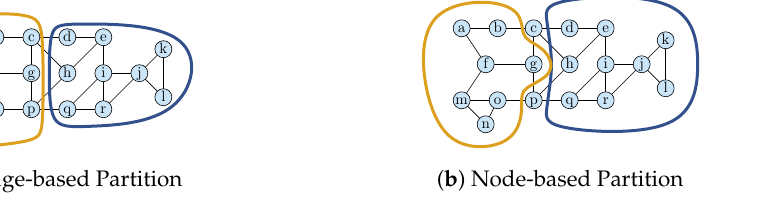
Figure 2. Examples of edge- and node-based